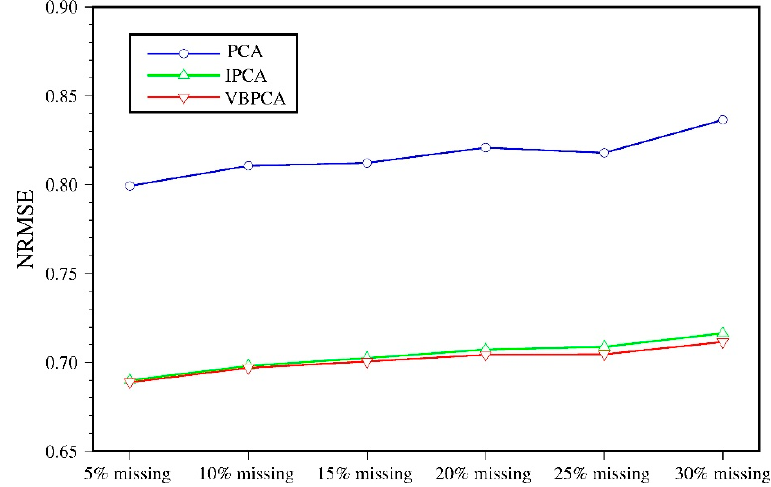
Figure 4. NRMSEs of PCA, IPCA, and VBPCA for various percentages of missing values.